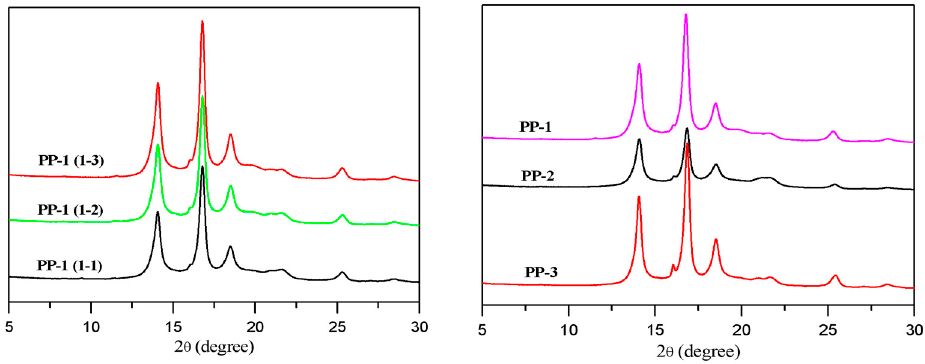
Figure 7. Wide x-ray diffraction results.